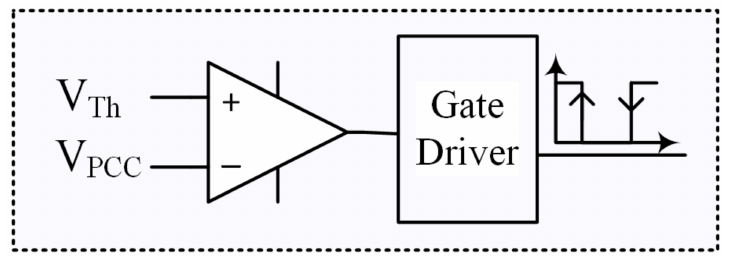
Figure 4. Control system of the conventional bridge-type FCL (BFCL).